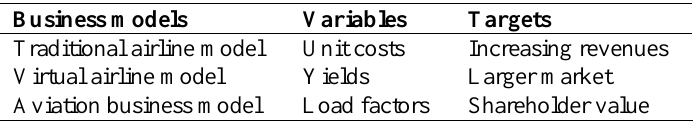
Table 2. Business models in the air transport business Business